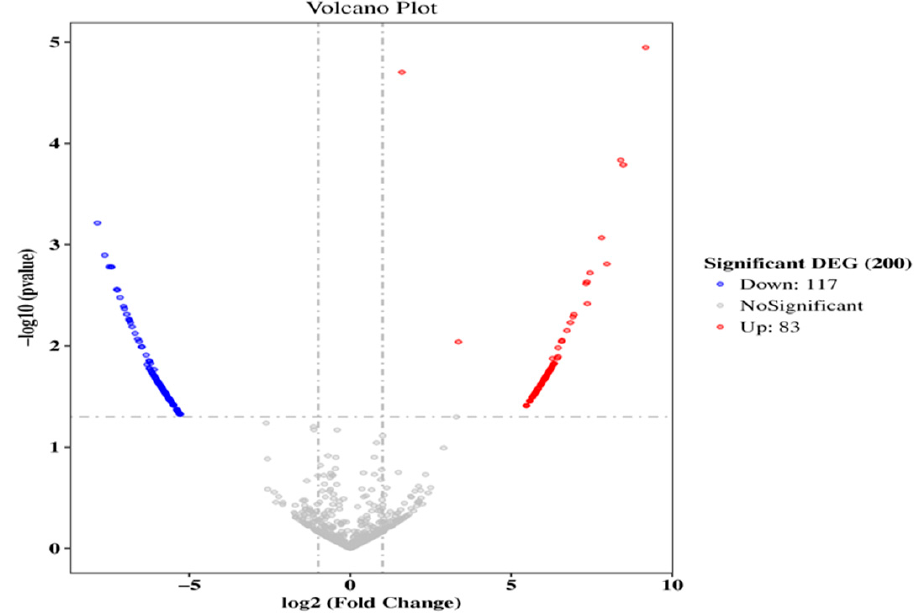
Figure 3. Main classifications of circular RNAs. Circular RNAs are mainly derived from exons, and the remaining sources are intergenic and introns.